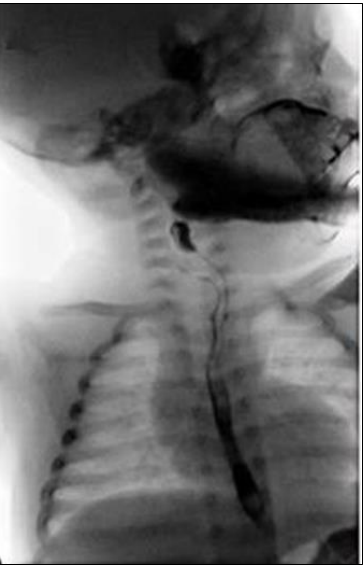
Figure 1: Tube esophagogram with gastrografin showing the contrast between esophagus and trachea indicating „H“-type esophageal fistula.